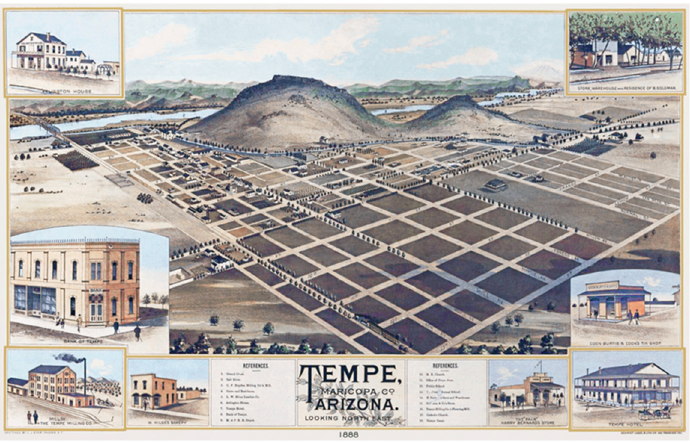
Figure 13. Tempe real estate boosterism map, 1888.